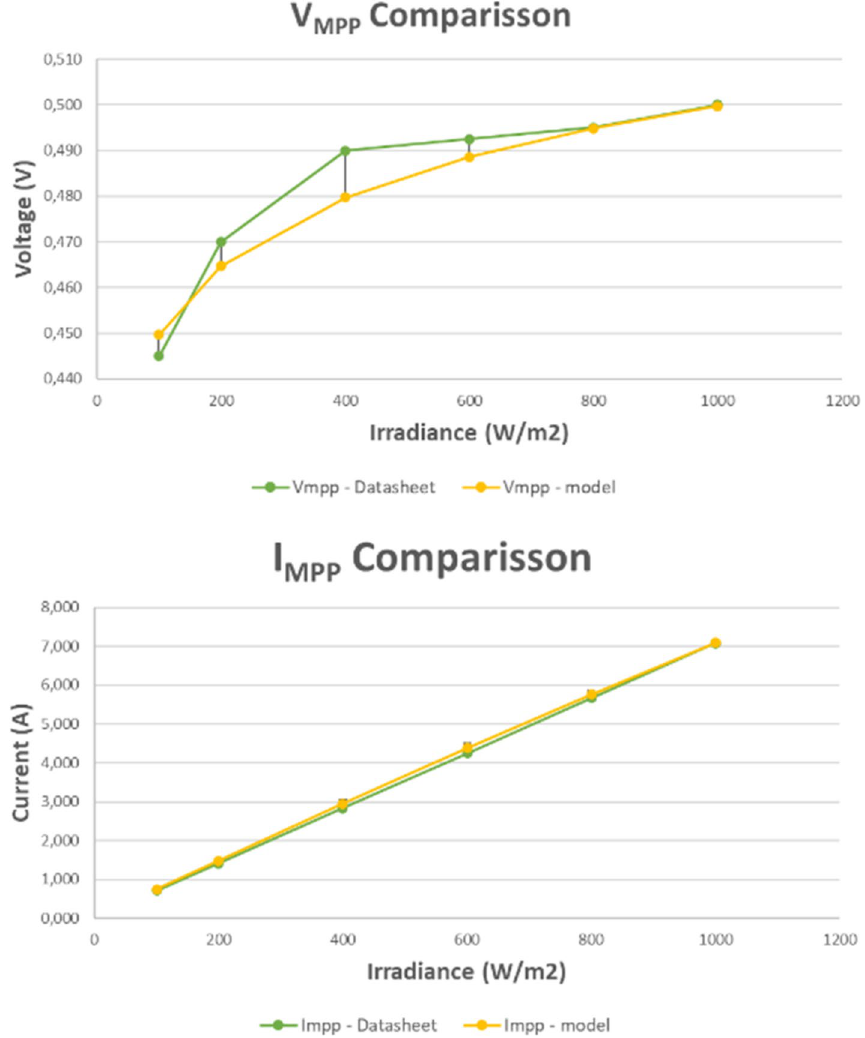
Fig. 3 Comparison between the values of Impp and Vmpp from the datasheet of the PV cell and the I mpp and V mpp generated by the